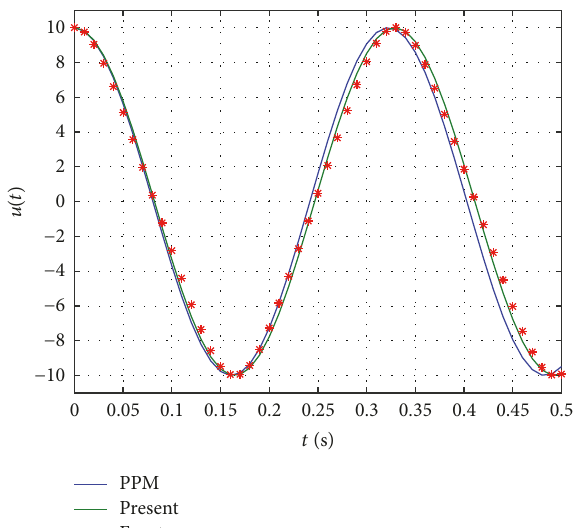
Figure 2: Comparison of time history diagram of displacement between the present, PPM, and exact solutions at 𝛼 = 5, 𝛽 = 5, 𝐴 = 10 , Example